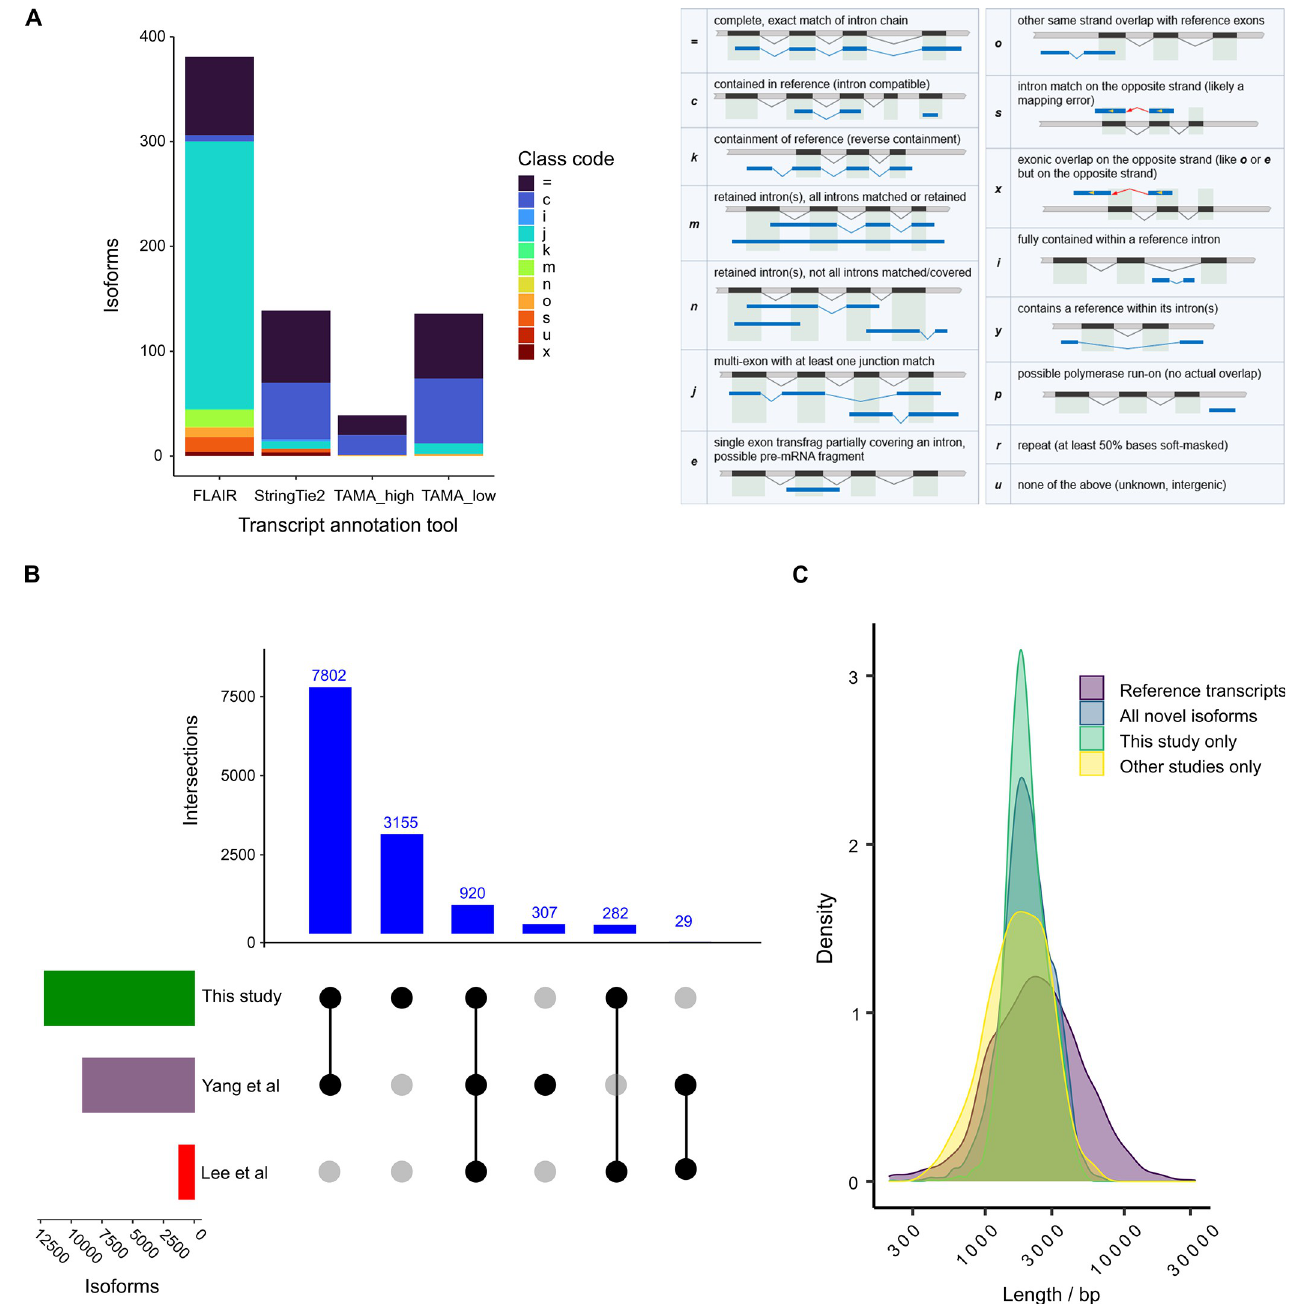
Fig 1. Isoform annotation and overview of the Plasmodium falciparum 3D7 novel isoform catalog. (A) Comparison of tools for transcript annotation. Candidate non-redundant transcript isoforms representing spike-in synthetic RNAs were identified from the same Nanopore cDNA dataset using three different tools: FLAIR [29], StringTie2 [28], and TAMA collapse [27]. The consistent and inconsistent isoforms outputted by FLAIR were combined. The TAMA collapse tool was run under “low” and “high” stringency settings [27], indicated as TAMA_low and TAMA_high, respectively. Isoforms assigned by each tool were compared with the chrIS annotation [26] using the GffCompare tool [30]. The isoforms matching the annotation (ground truth) are present in the “=“ class; other classes not matching the annotation are indicated by the class codes c, k, m, n, j, e, o, s, x, i, and u in decreasing order of priority, i.e., divergence from the ground truth. Class code descriptions are shown on the right (reproduced with permission from [30]). Note that classes c and j include truncated isoforms, s and x include isoforms on the opposite (antisense) strand of the annotated transcript, and class u isoforms map outside of exonic regions. (B) Study datasets supporting the catalog of 12,495 Plasmodium falciparum 3D7 novel isoforms (not currently annotated as transcripts in PlasmoDB [16]). Intersections are shown by UpSetR plot [31], which is a matrix-based representation of set sizes and their intersections. Matrix rows represent the sets (independent studies) and columns represent intersections of novel isoforms supported by studies. The numbers of isoforms for each study are shown by the